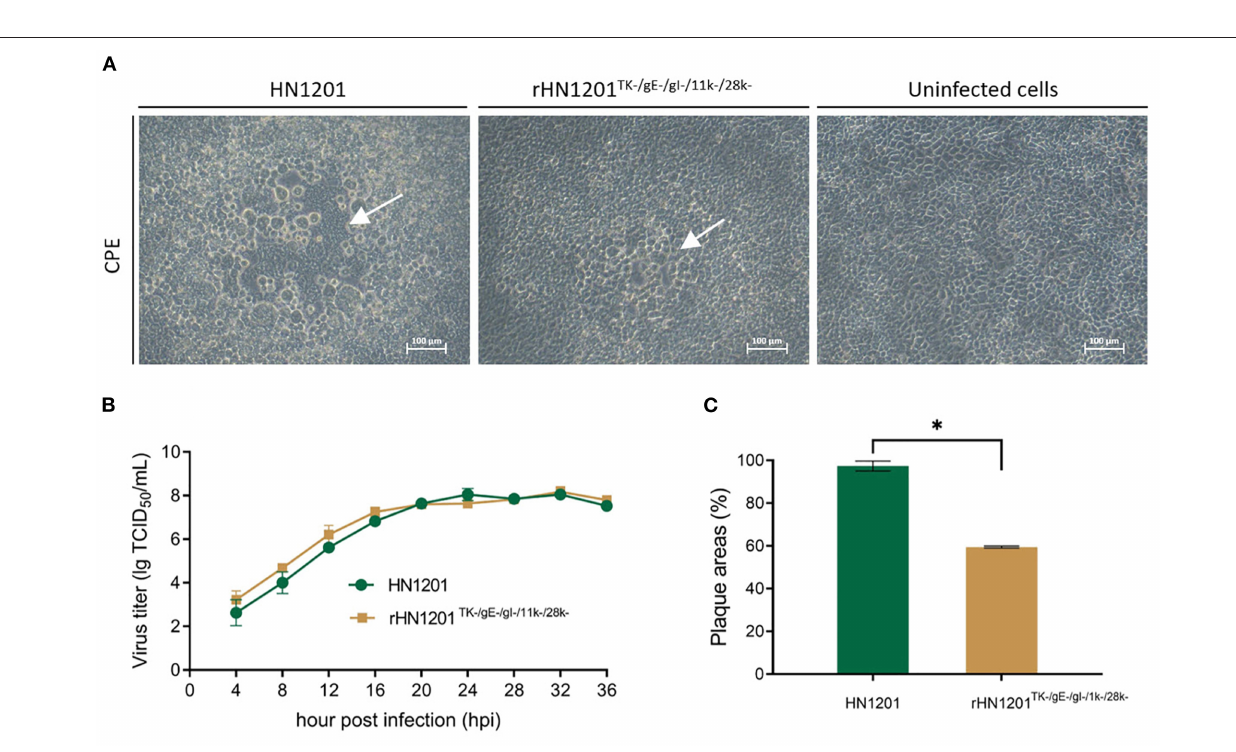
Frontiers in Veterinary Science |